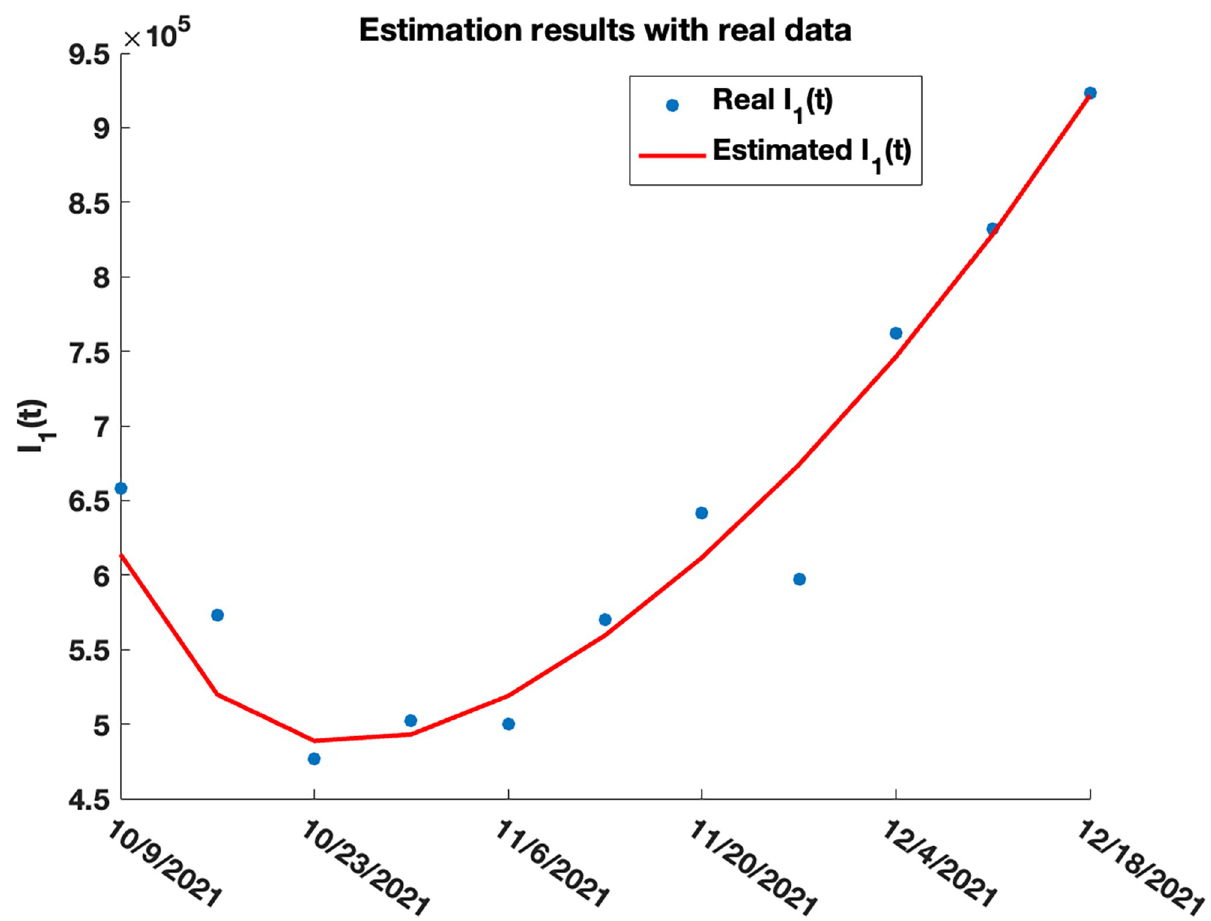
Fig 9. Real (blue) and estimated (red) COVID-19 weekly cases for the Delta variant in the United